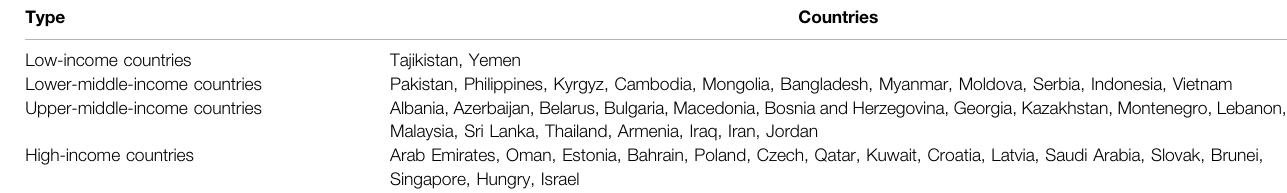
TABLE 1 | The classi fi cation of B&R countries.